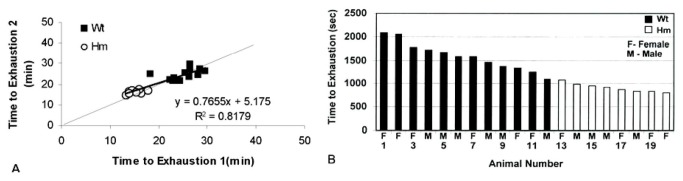
Exercise Capacity of wild type and mutant rats.Rats were exercised to exhaustion on a treadmill (see Materials and Methods). The running protocol was repeated twice. A. Reproducibility of measured maximal exercise capacity. The correlation of the 2 measurements was demonstrated by the large R2 value, near unity of slope, and small intercept; B. Wild type and homozygote mutant rats had significantly different maximal exercise capacity, defined as time to exhaustion. The maximal exercise capacity averaged 9.3 minutes longer in wild type rats than in mutants. P-value <0.001 was based on a T-test. Wt; wild type; Hm; Homozygous mutant; F; female; M; Male.